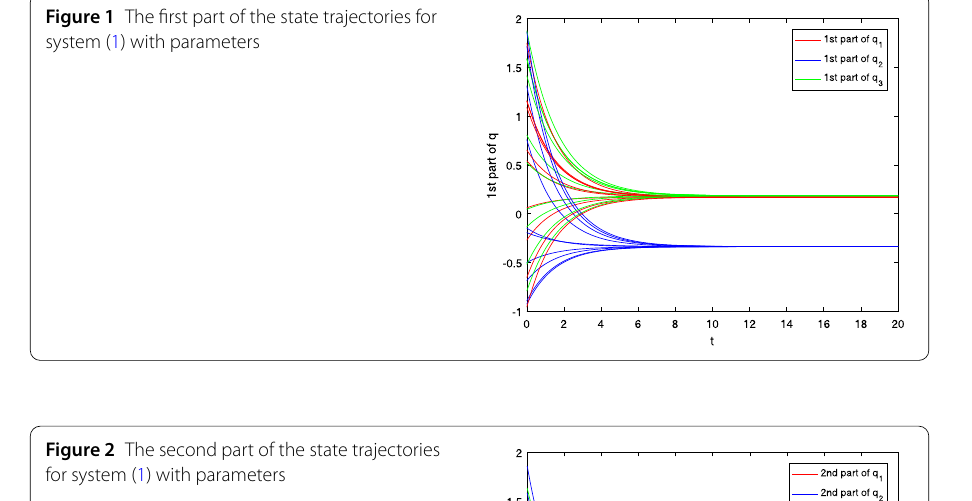
Figure 2 The second part of the state trajectories for system (1) with parameters